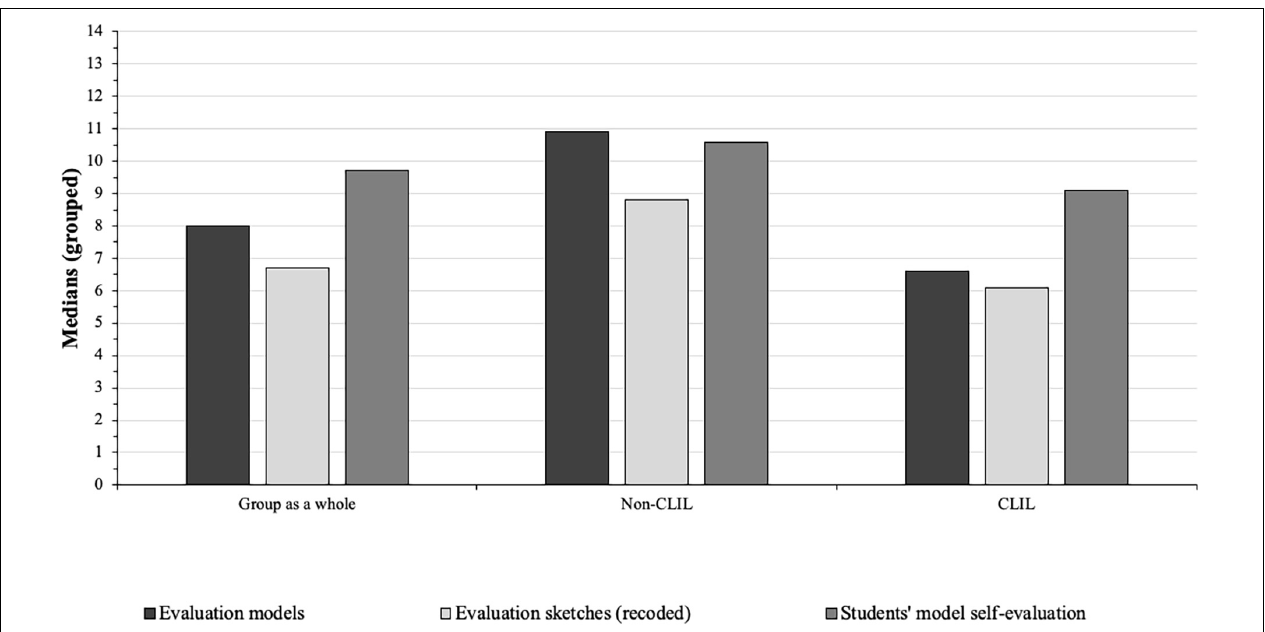
FIGURE 8 | Differences between non-CLIL and CLIL learners for model evaluation, recoded evaluation of students’ sketches and students’ model